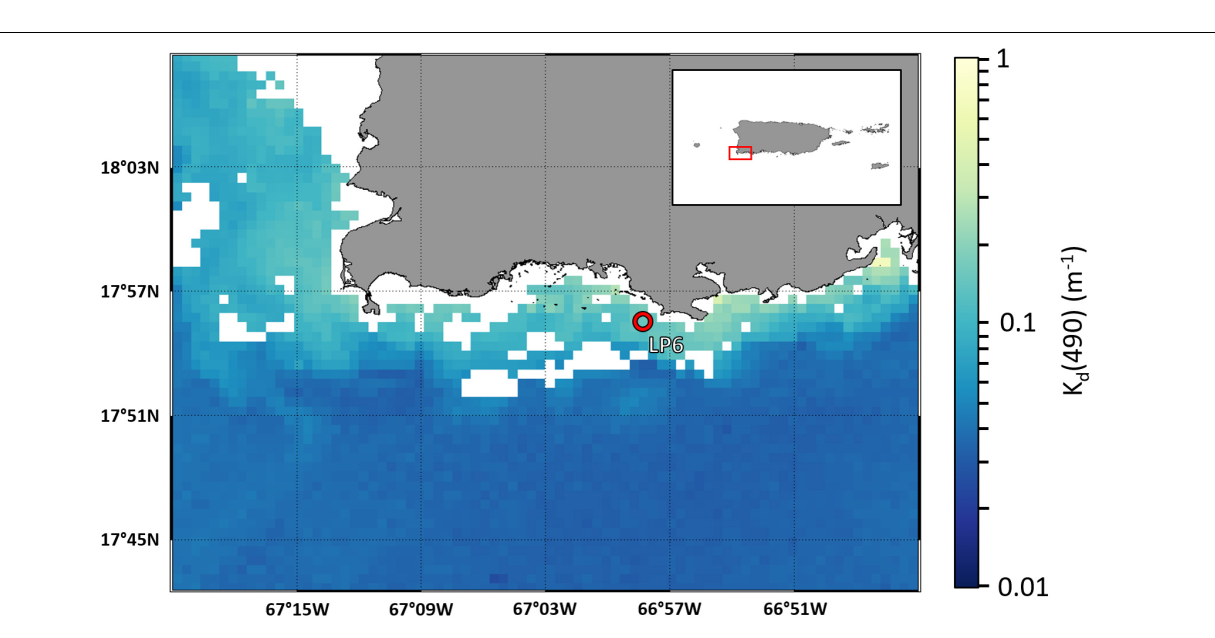
FIGURE 3 | Map of VIIRS K d (490) for southwestern Puerto Rico for November 9, 2016 (750 m pixel resolution). White areas are missing data due to cloud cover or flagged due to poor quality. The red circle shows the location where 22 in situ optical data measurements were taken between 2016 and 2019 using a Sea-Bird Scientific HyperPro